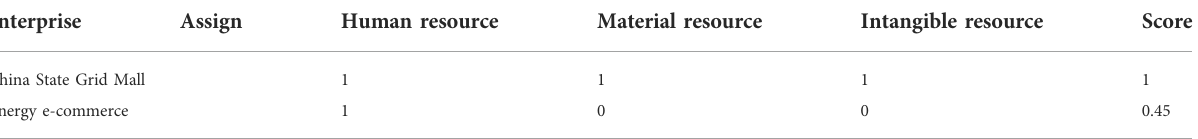
TABLE 6 Service-oriented enterprise resource key score.